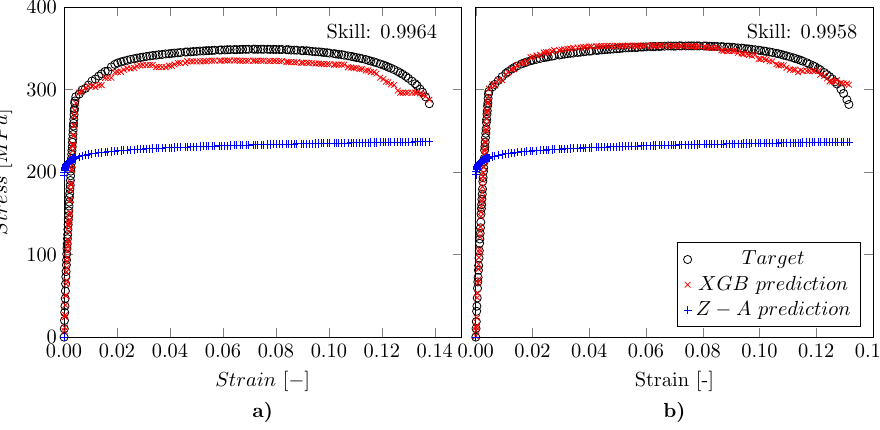
Figure 12. The two curves being characterized by the highest test performance when applying the XGB model as directly compared to predictions made by the Z–A model. Subfigure ( a ) shows the T6 as-received condition at a strain rate of 0.01 s − 1 at 200 ◦ C whereas in ( b ) the Tool 24 ◦ C condition at a strain rate of 0.1 s − 1 at a temperature of 200 ◦ C can be